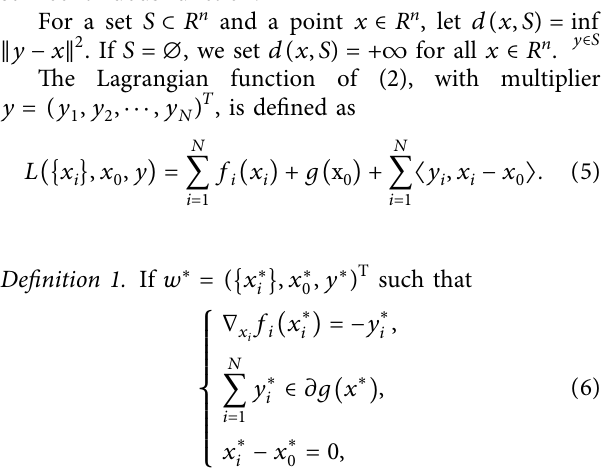
Algorithm 1. Inertial ADMM (IADMM). Choose x 0